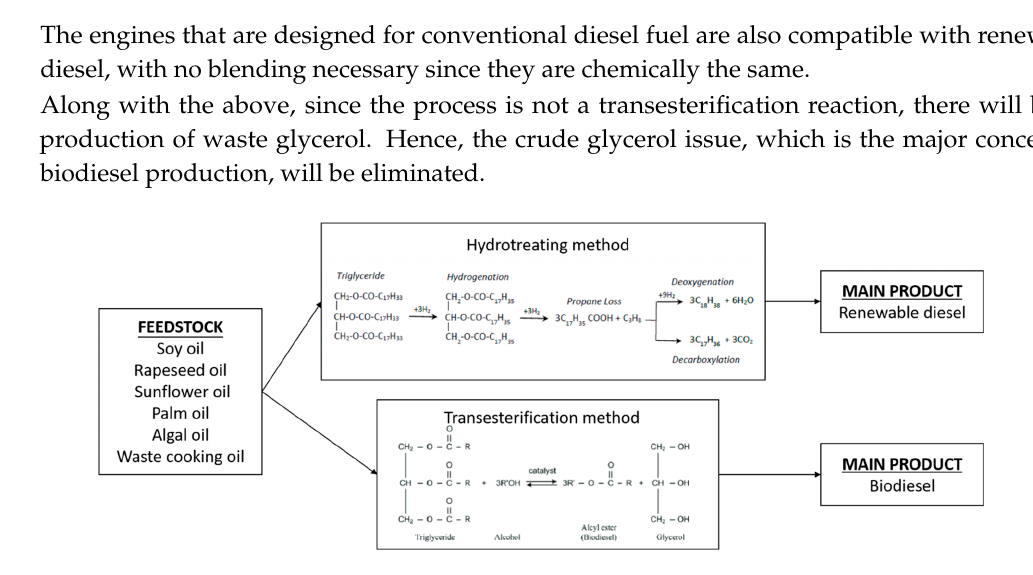
Figure 1. Processing for renewable diesel and biodiesel production.